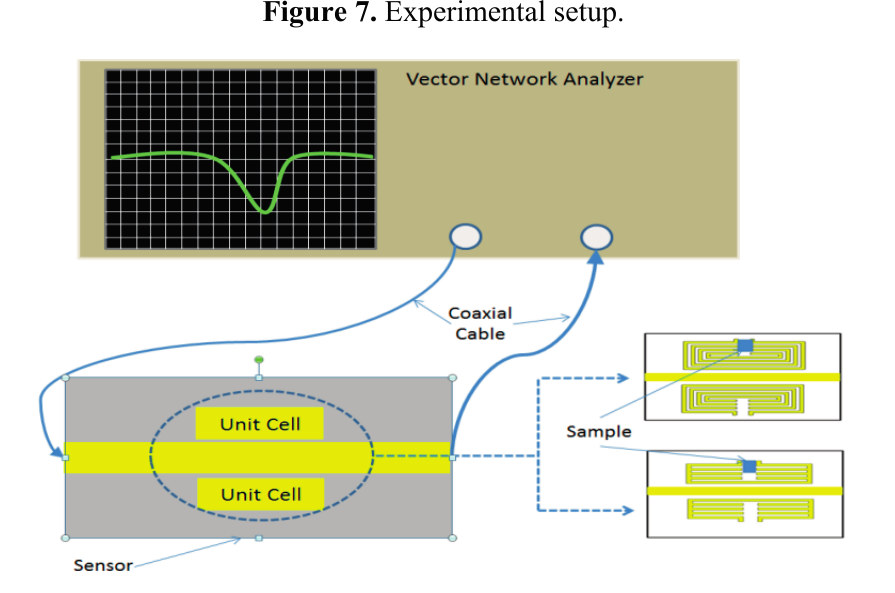
Table 3. Simulated and measured resonant frequency, Q factor and S